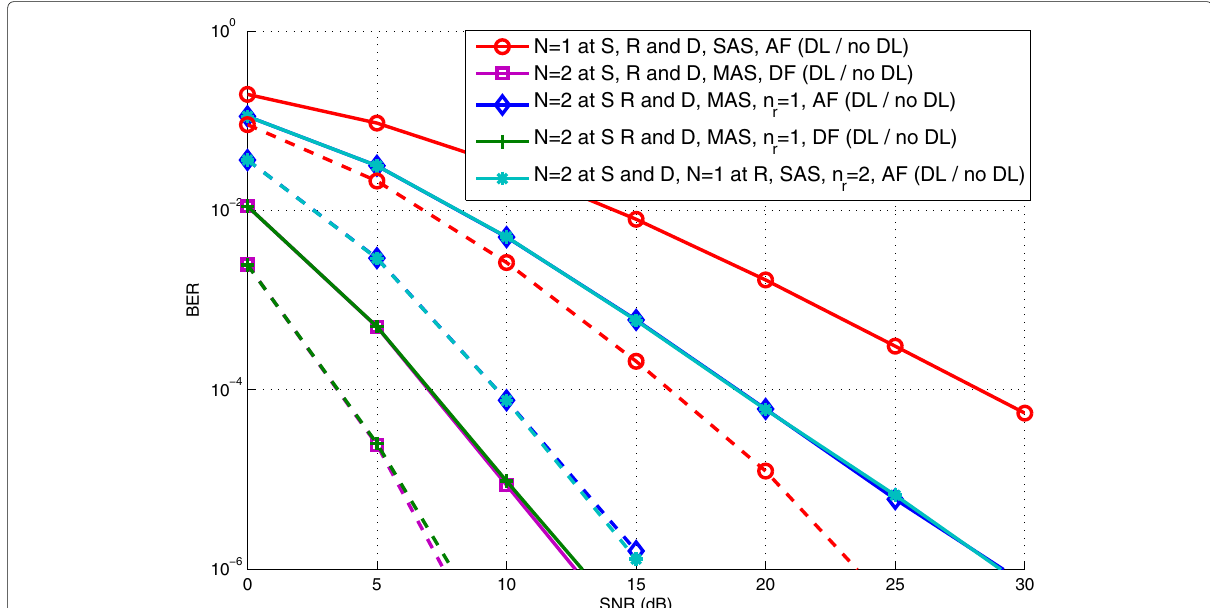
Fig. 2 BER performance vs. SNR for SAS and MAS employing the Alamouti schemes without the delay